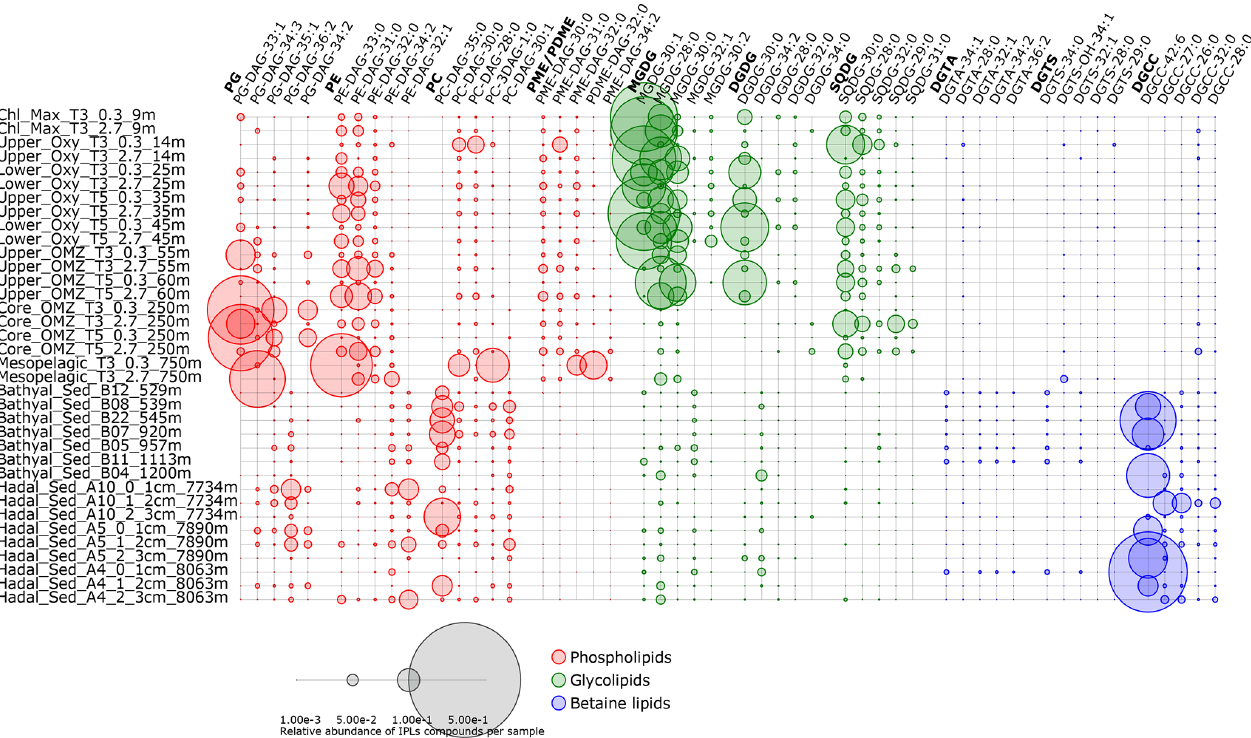
Figure 7. Relative abundance of the five most abundant individual IPLs contributing to each IPL class. Circle size is proportional to the relative abundance of IPL compounds per sample. Samples are organized along the vertical axis by depth, whereas phospholipids, glycolipids, and betaine lipids are shown in colors. The legend provides a scale for circumference